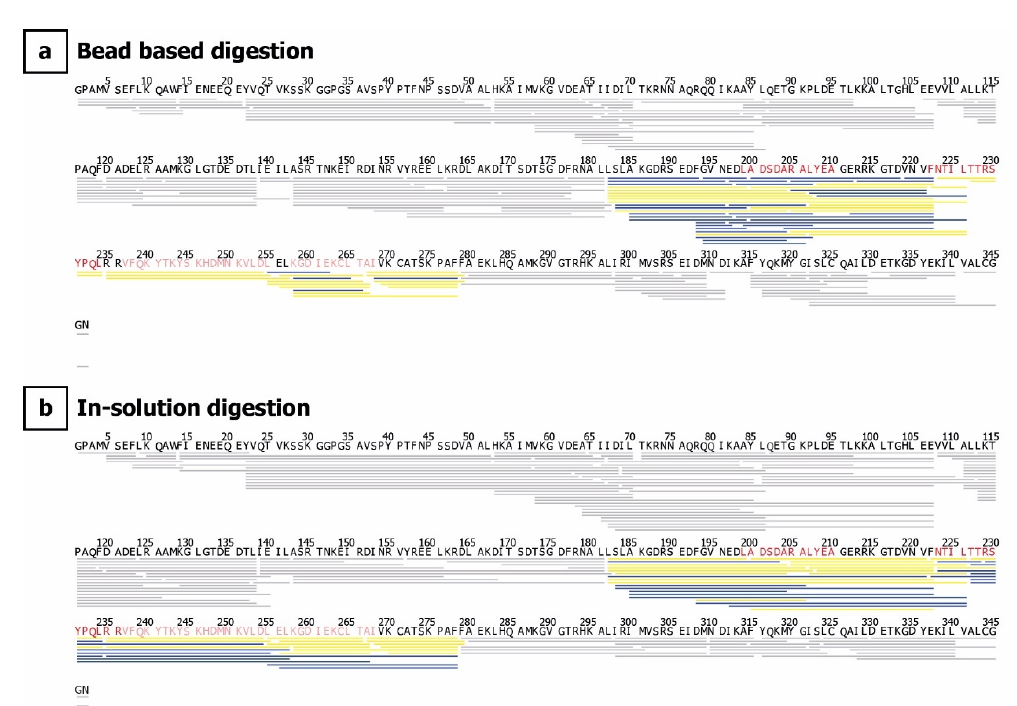
Figure 4. Sequence coverage (100%) and coverage redundancy of the bead-based pepsin digestion ( a ) and the in-solution pepsin digestion ( b ). Identical peptides within the antibody–ANXA1 interaction region are depicted in yellow; peptides obtained in one of the two approaches only are shown in blue. Amino acids highlighted in red show the refined interaction region, with significant deuteration differences in the covering peptides.